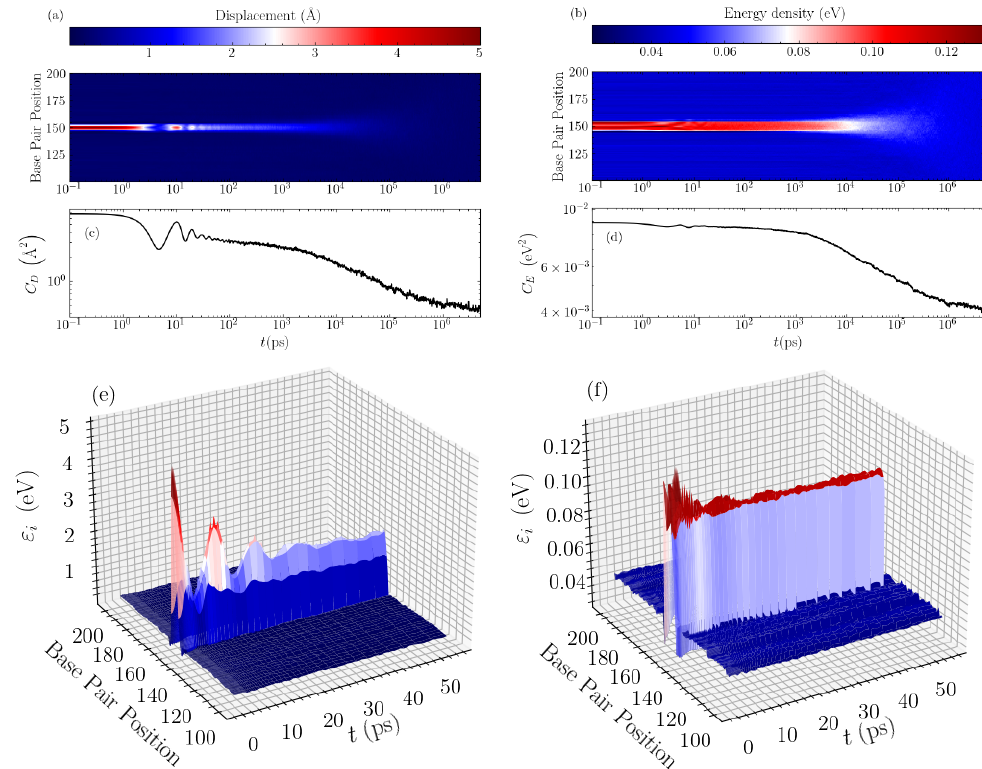
Figure 3. The evolution of the averaged displacement and energy density profiles through time, for the case of a GC homopolymer with an initial bubble of amplitude h = 5 Å and width w = 11 base pairs. The left column shows data for the displacements and the right column for the energy densities. ( a , b ) show a density plot of the long-time evolution profile of the displacements and energy densities, respectively, with the intensity labelled according to the colorbar above the panels. The data are shown for the central 100 base pairs of the sequence. The corresponding average autocorrelation functions, C D ( t ) and C E ( t ) , are presented below, in ( c , d ) respectively, for a direct comparison. A 3D representation of the early stage of the evolution is depicted in ( e , f ) for the displacements and energy densities,